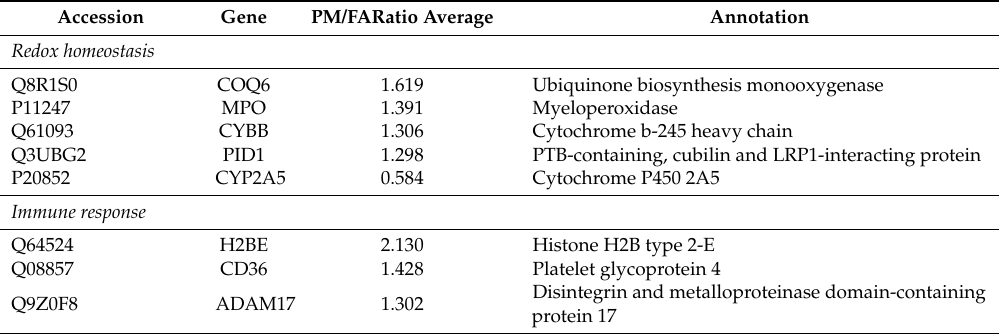
Table 3. Identified proteins from PM 2.5 -exposed